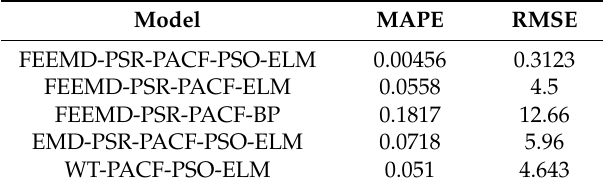
Table 10. A comparison of the different forecasting models under Beijing’s